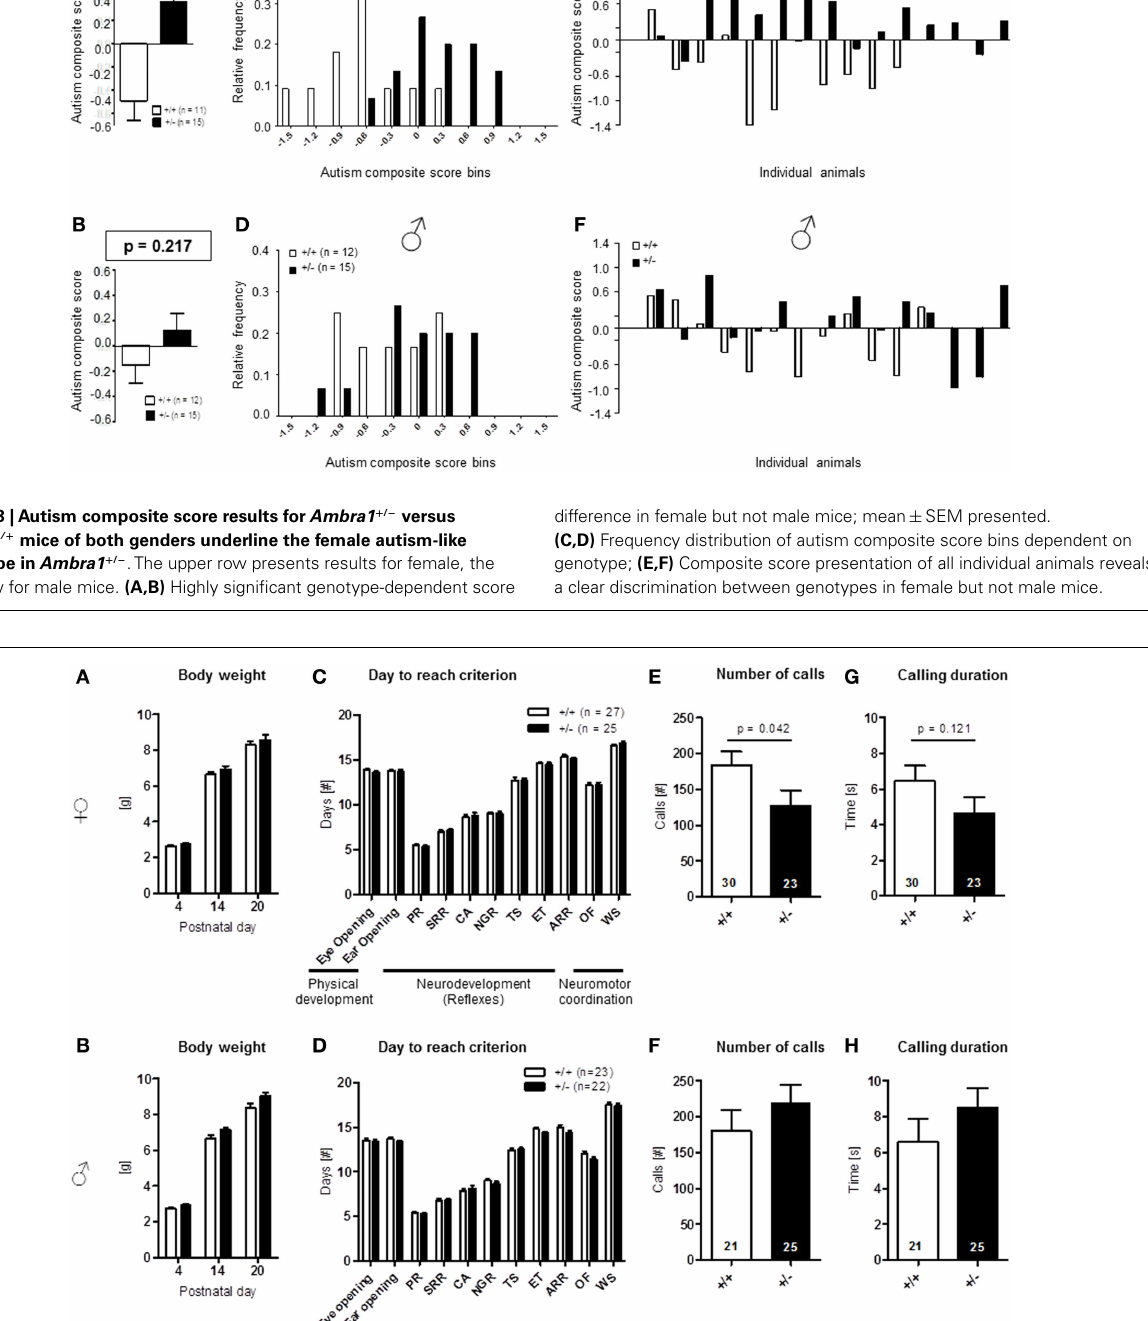
negative geotaxis reflex;TS, tactile startle; ET, ear twitch; ARR, air righting reflex), and neuromotor coordination (OF, open field traversal;WS, wire suspension). Overall test results are expressed as days to reach criterion. (E–H) Ultrasound vocalization of pups briefly separated from their mother on postnatal day 8/9. Mean ± SEM presented; respective sample sizes are indicated in the